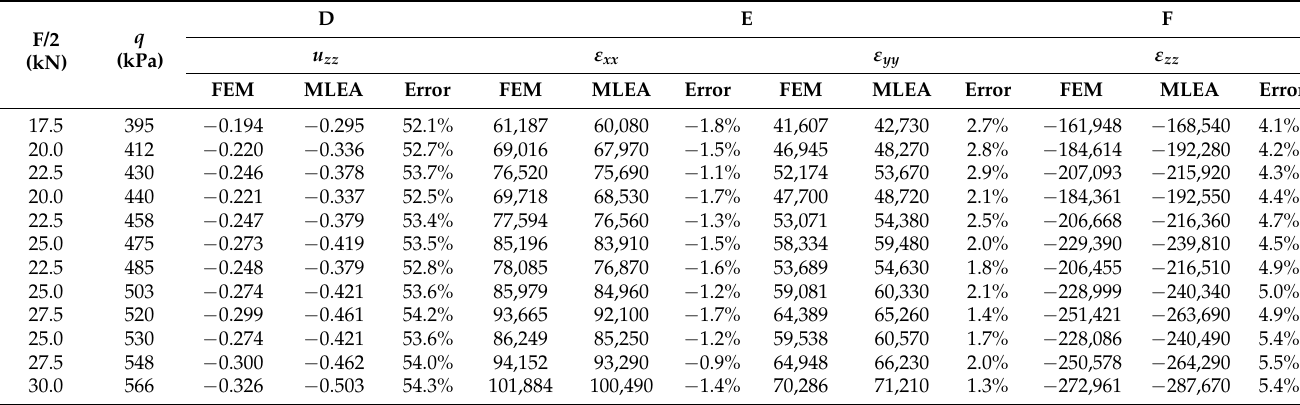
Table 12. Critical stresses and strains straight below the tyre based on the twin tyre finite element simulation (FEM) and the substituting circular plate model